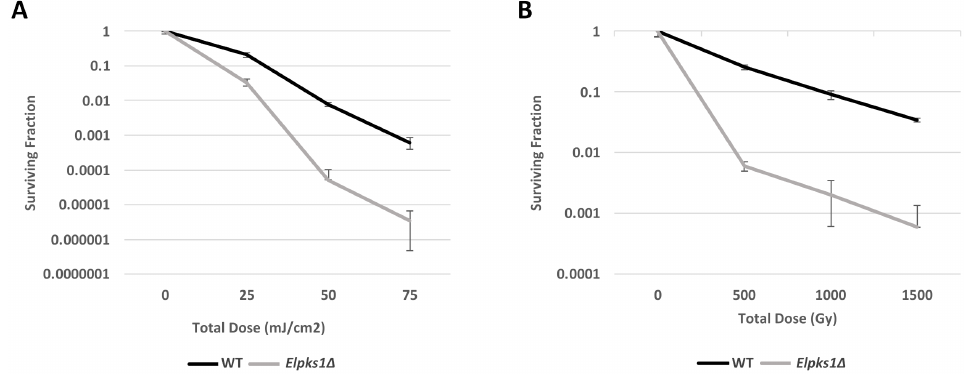
Figure 3. Survival rate of E. lecanii-corni WT and Elpks1 ∆ cells following exposure varying total doses of ( A ) UV-C radiation with dose rate of 0.273 mJ/cm 2 , and ( B ) γ -radiation with a dose rate of 36